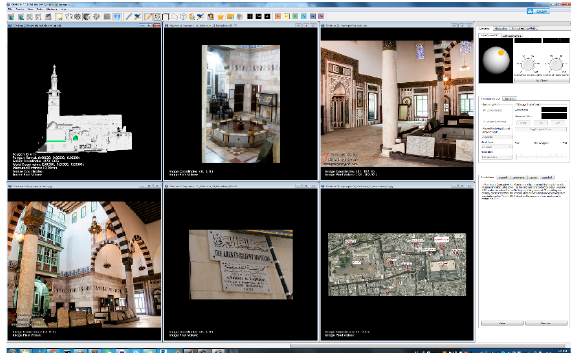
Figure 4. Screenshot from CHER-Ob showing Al-Jakmakiyah